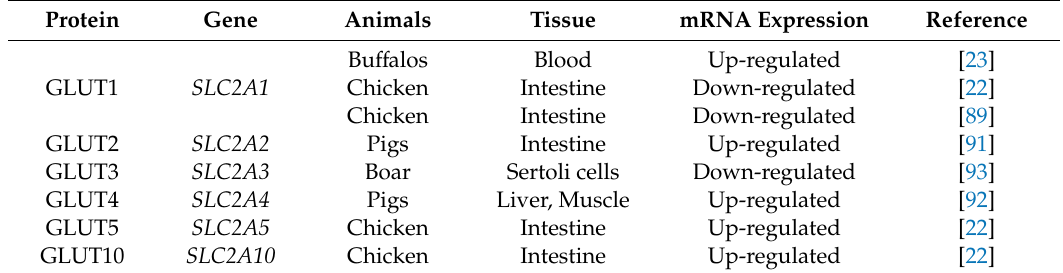
Table 3. mRNA expression of SLC2A genes in di ff erent animals and tissue under heat stress. Protein Gene Animals Tissue mRNA Expression Reference Bu ff alos Blood Up-regulated GLUT1 Chicken Intestine Chicken Intestine Intestine Liver,